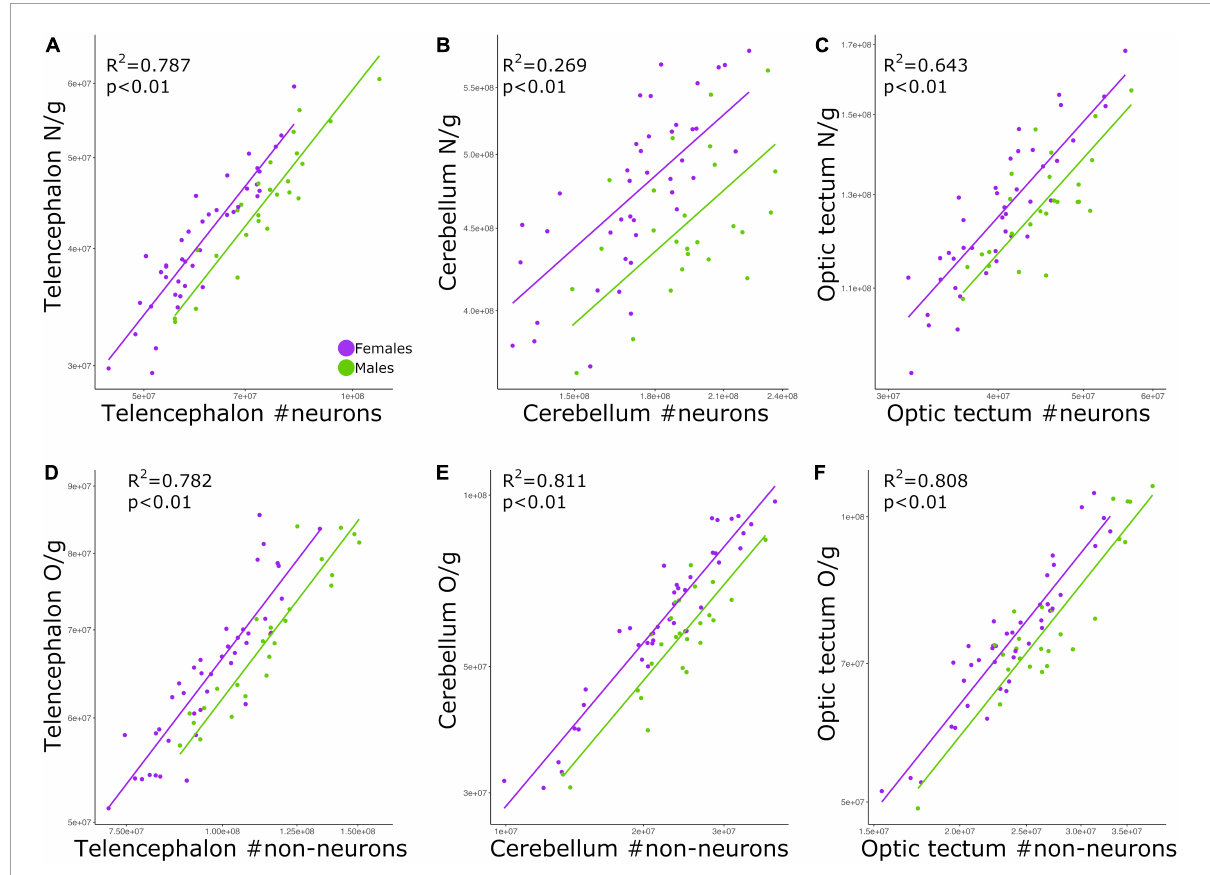
FIGURE4 Scatterplots of (A) neuronal density in the telencephalon against neuron numbers in the telencephalon, (B) neuronal density in the cerebellum against neuron numbers in the cerebellum, (C) neuronal density in the optic tectum against neuron numbers in the optic tectum, (D) non-neuronal density in the telencephalon against non-neuronal cell numbers in the telencephalon, (E) non-neuronal density in the cerebellum against non-neuronal cell numbers in the cerebellum, and (F) non-neuronal density in the optic tectum against non-neuronal cell numbers in the optic tectum. In all graphs, males are shown in green, and females are shown in purple. N/g, neuronal density; O/g, non-neuronal